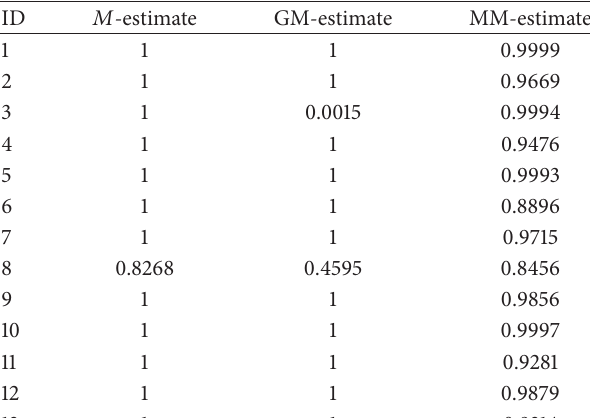
Table 4: Final weights from robust regressions.